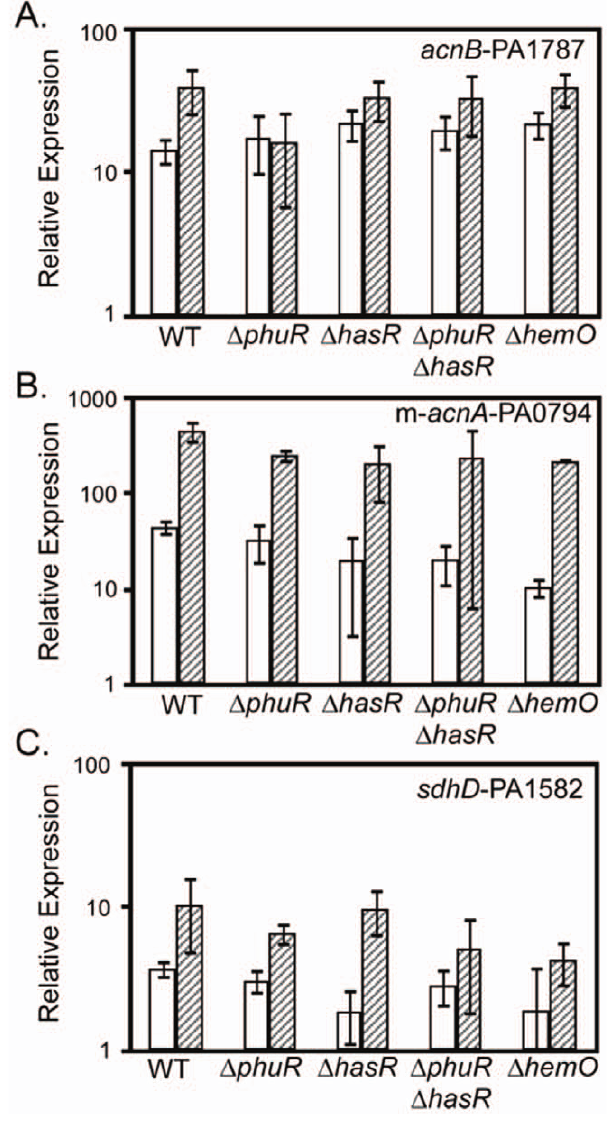
Figure 7. PhuR and HasR are important for heme regulation of PrrF target mRNAs. Heme utilization mutants lacking one or both outer membrane heme receptors or the HemO heme oxygenase were grown for 18 hours in CM9 + 1% glycerol with no added iron (white bars) or 40 m M hemin (hatched bars). RNA was then isolated and analyzed by qRT-PCR for expression of (A) acnB -PA1787, (B) m- acnA - PA0794, and (C) sdhD -PA1582, as described in the Materials and Methods. Error bars show the standard deviation of at least three independent experiments.